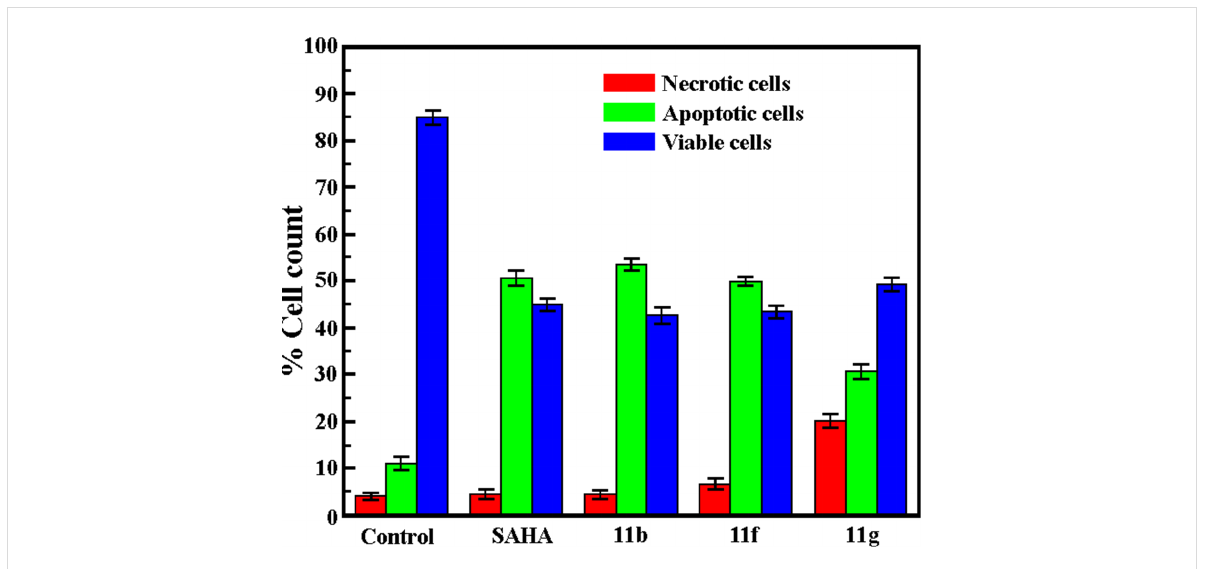
Figure 3: Percent of cell death by LDH assay at a GI 50 dose of SAHA, 11b , 11f and 11g after 24 h incubation along with cytotoxicity, percentage of apoptotic and necrotic cell death was also calculated. Data are representative of three independent experiments.